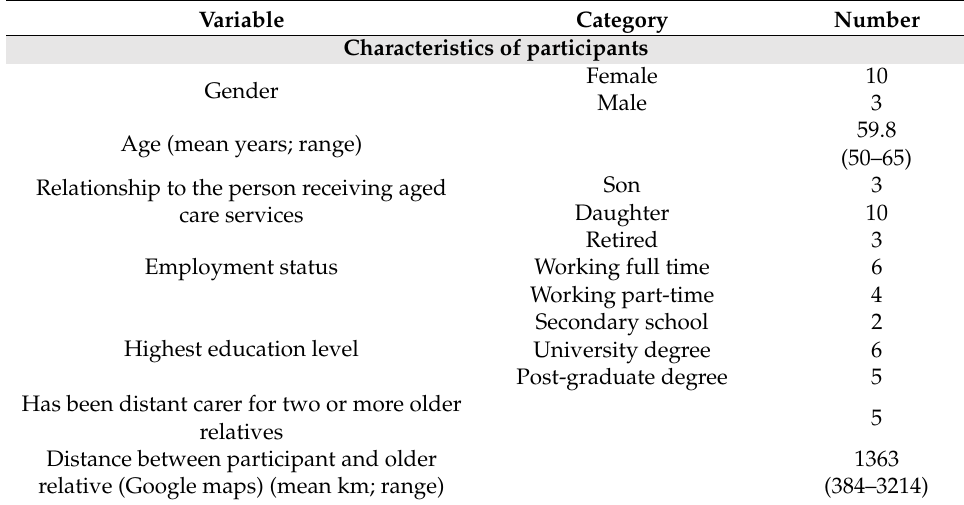
Table 1. Characteristics of the sample and their older